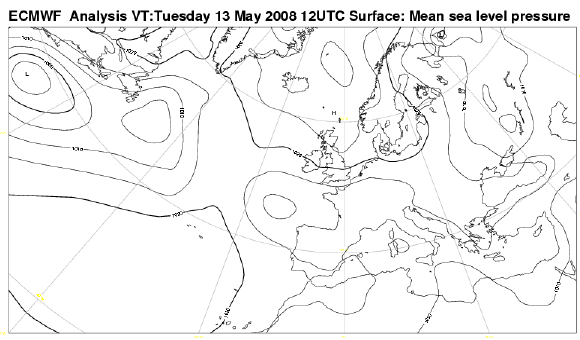
Figure 1. Mean sea-level pressure from ERA-Interim data on 13 May 2008 during 2 Fig. 1. Mean sea-level pressure from ERA-Interim data on 13 May LONGREX-2 period. 3 2008 during LONGREX-2